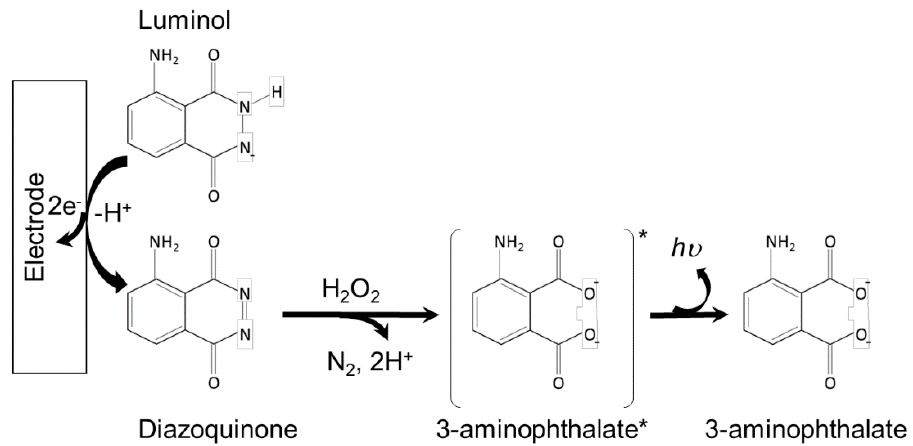
Figure 1. Scheme showing the ECL mechanism of luminol with hydrogen peroxide. Reproduced from reference [14]. Reproduced and adapted with permission of MDPI.